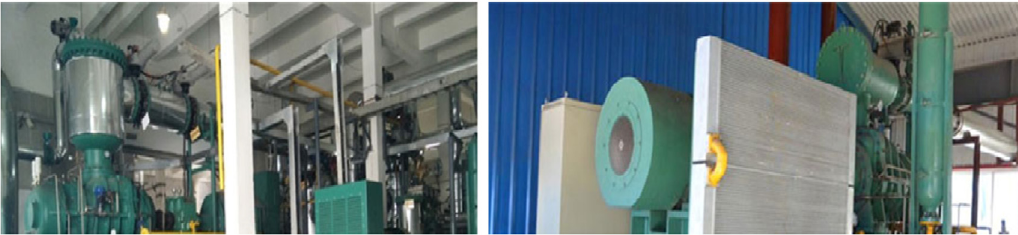
Figure 8. The screw expanding power generator of Jiangsu Chengxing Phosphoru—Chemical Co. Ltd.